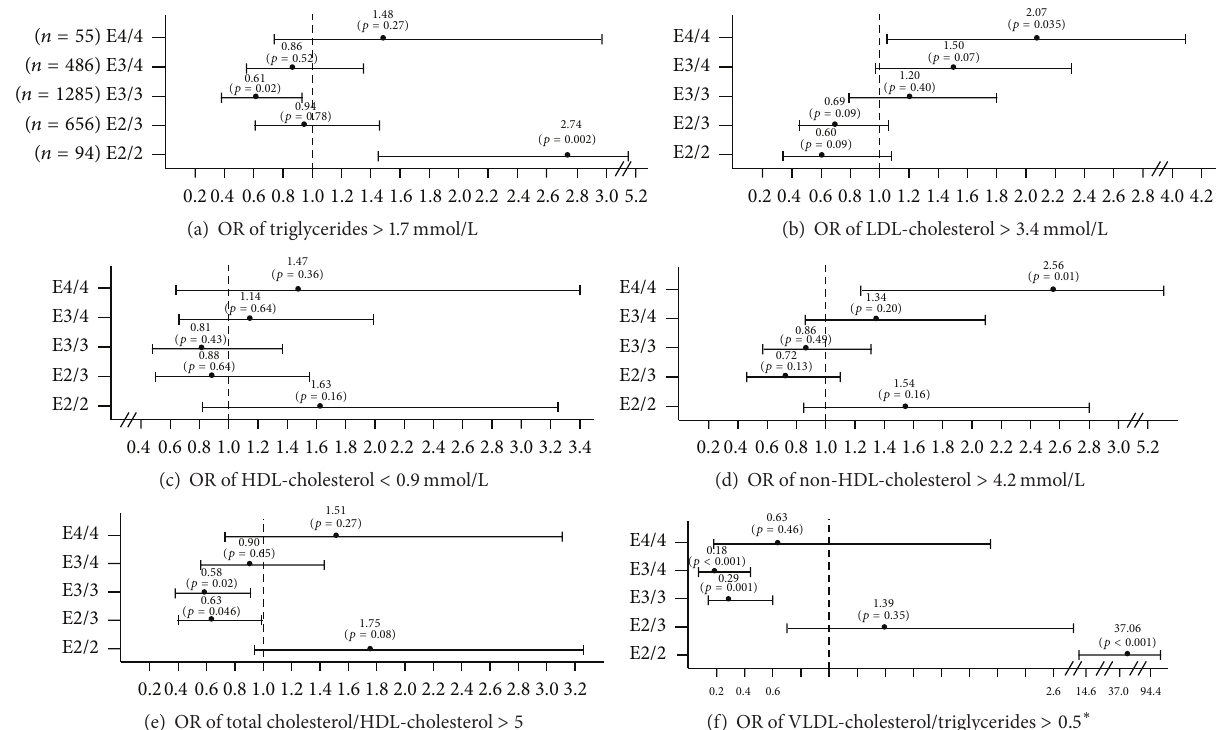
Figure 2: Estimated relative risk (odds ratio, OR) of hyperlipidemia associated with the apolipoprotein E genotype, among a subsample of 1,531 subjects. The ApoE2/4 genotype was considered as the reference group to which an odds ratio of one was set for comparison purposes. Odds ratio ± 95% CI. Covariates included in mode l are age, sex, type 2 diabetes, and